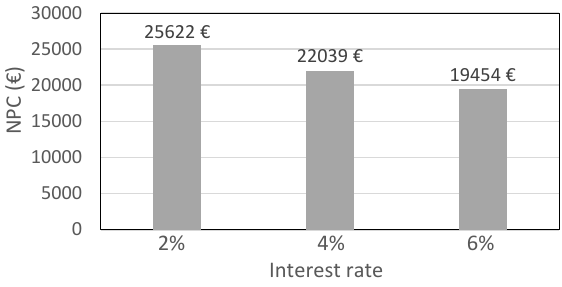
Figure 10. PV + Diesel + Battery systems. Effect on the NPC of the interest rate.